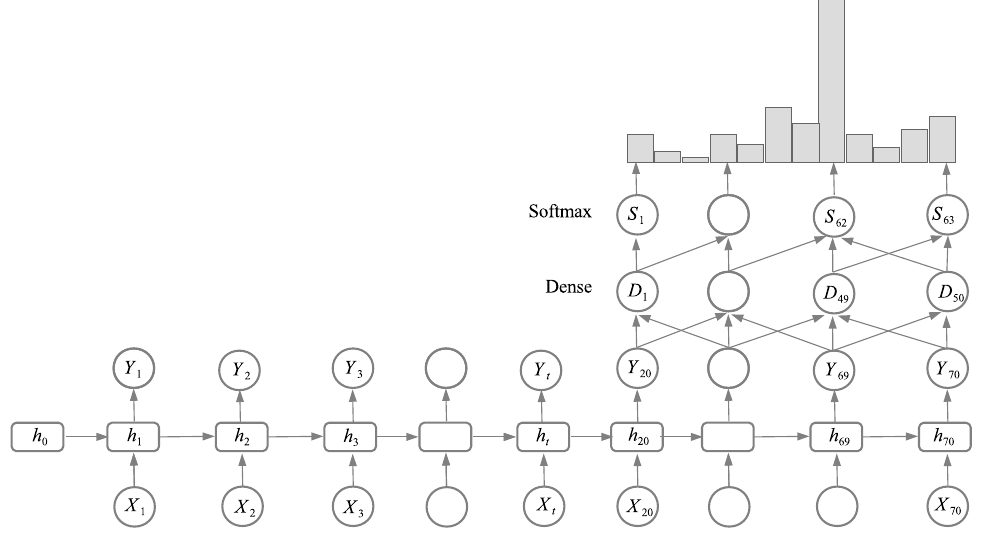
Figure 5. A simple RNN with 70 LSTM cells, with an overlap of one dense layer and a softmax activation output.